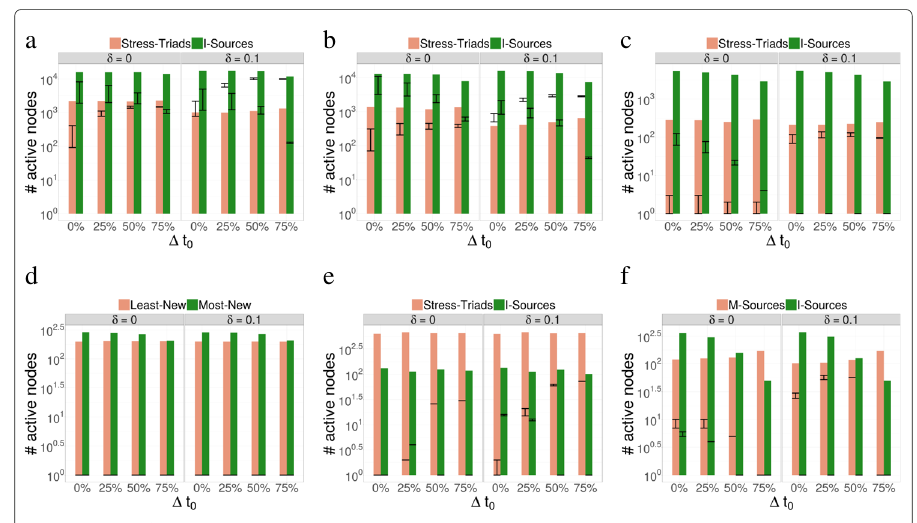
Fig. 14 npC - F 2 DLT : Spread, number of deactivated nodes, and number of deactivations (log scale) by varying start-delay ( (cid:10) t 0 ) of the “good” campaign (second bars), for δ = { 0,0.1 } , k = 50. a Epinions. b Slashdot. c Wiki-Conflict. d Wiki-Conflict. e Wiki-Vote. f